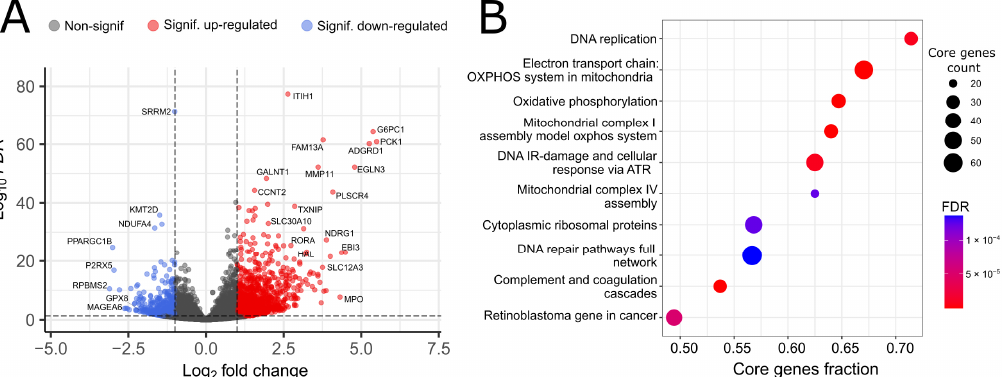
Figure 2. Transcriptomic profiling of HepG2 WT and TOMM34 KO cells. ( A ) Volcano plot showing differentially expressed genes between WT and KO cells. FDR—false discovery rate. ( B ) Gene Set Enrichment Analysis of differentially expressed genes between WT and KO cells. Core genes is the subset of genes in the geneset contributing to the enrichment signal.